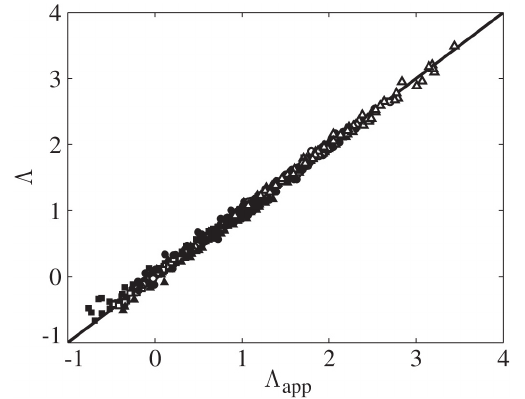
Fig. 4. Relationship between 3 and 3 app .